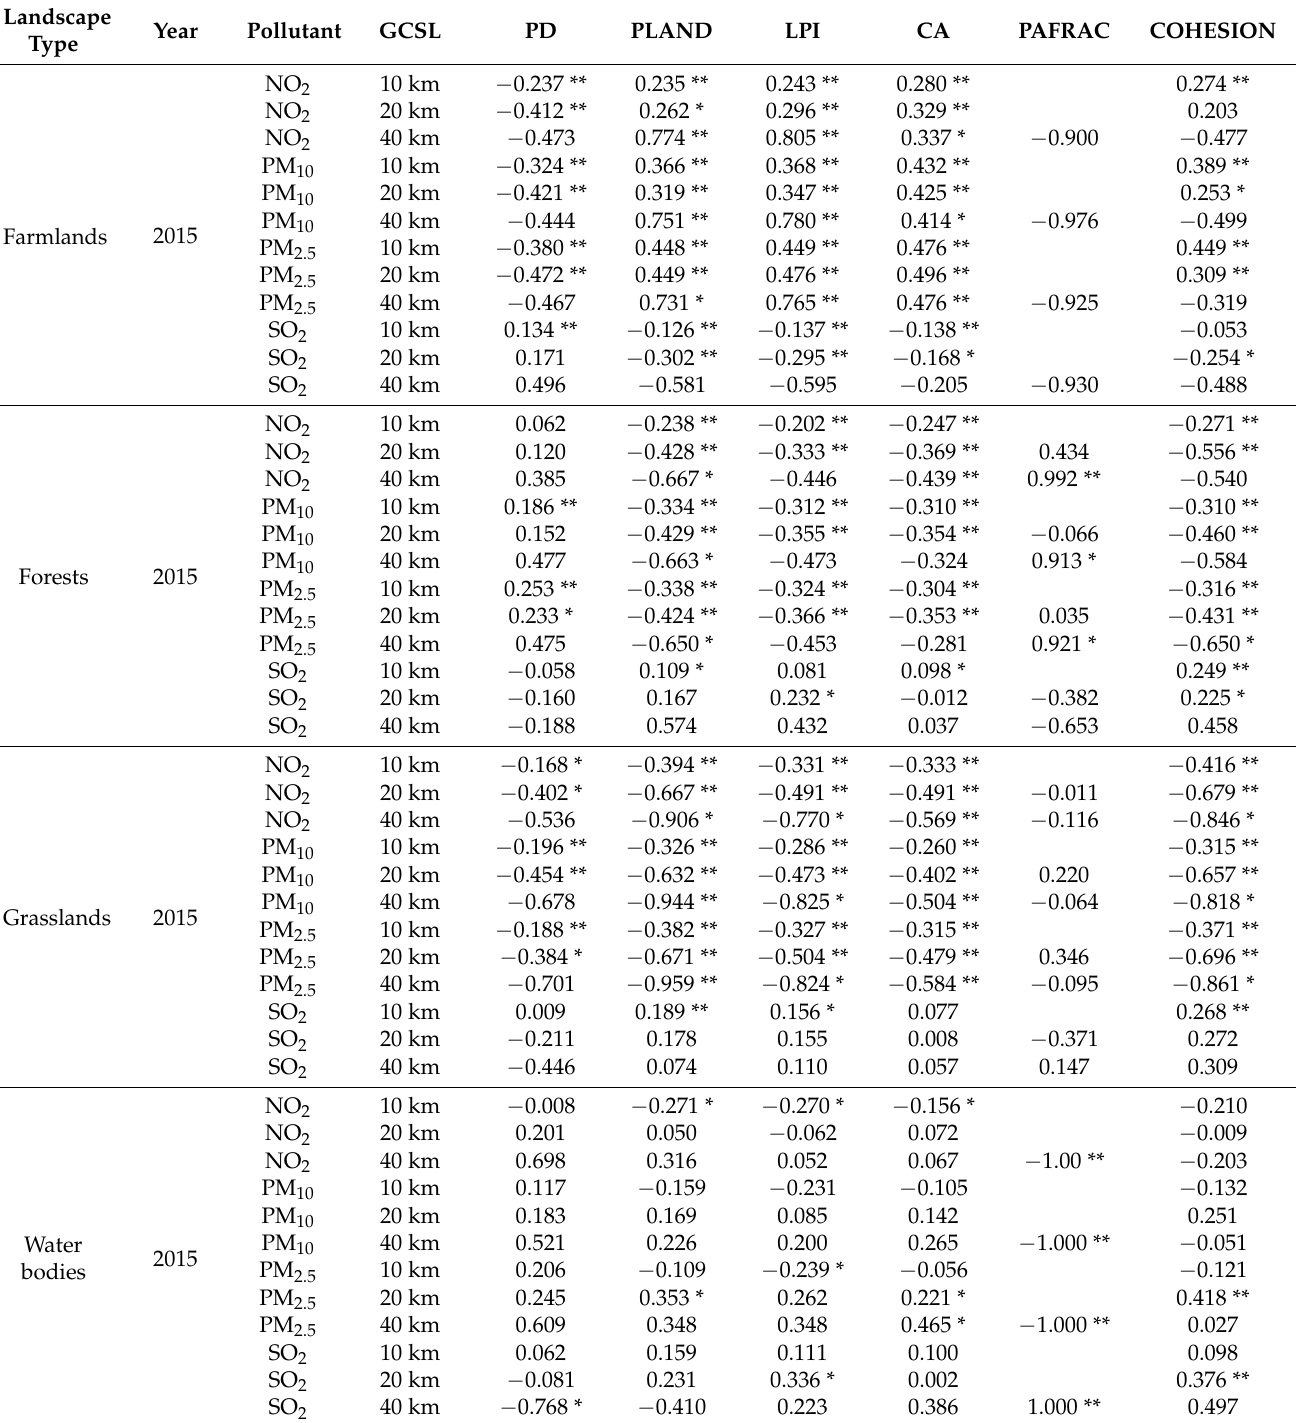
Table 5. Correlation coefficients between the patch-type-level landscape pattern metrics and the concentrations of the four pollutants at each